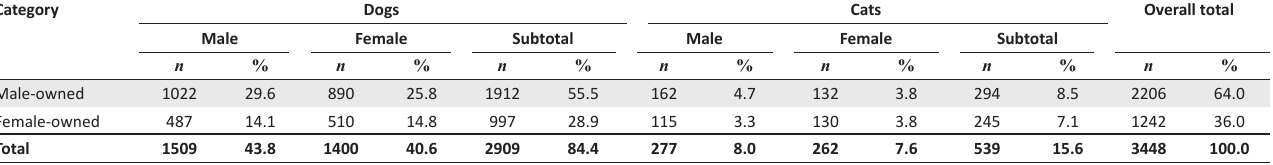
TABLE 2: Overall categorical proportions of pets brought in for sterilisation. Category